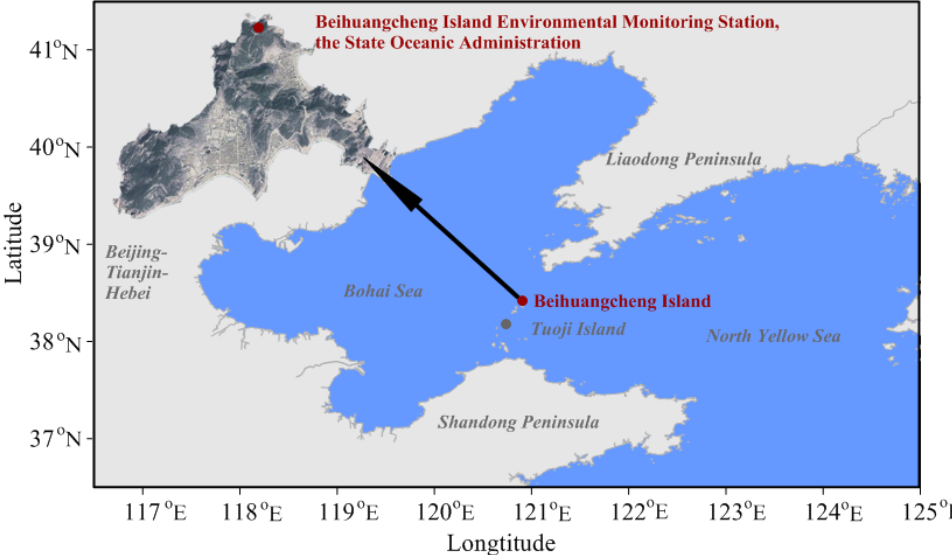
Figure 1. The location of the sampling site on the Beihuangcheng Island.